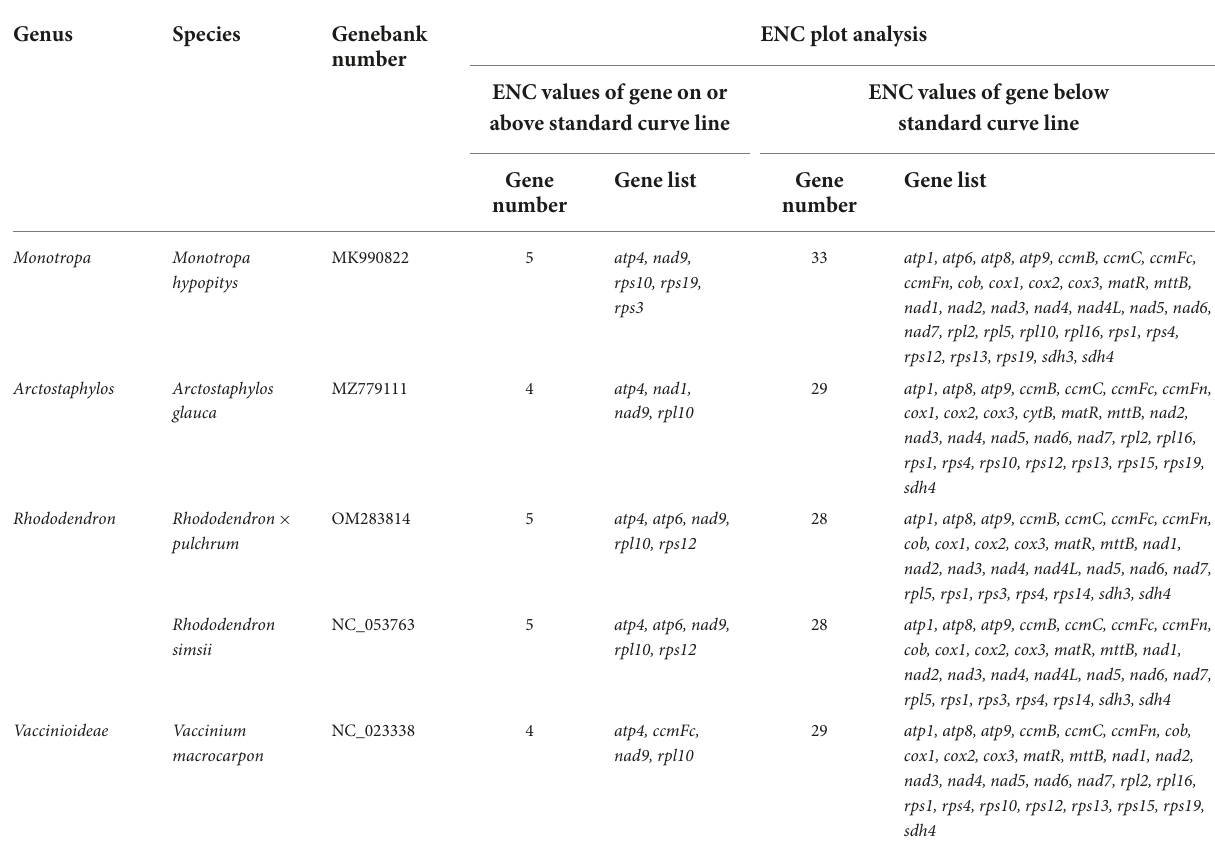
TABLE 3 Plot of ENC of genes in 5 Ericaceae species mitochondrial genomes. Genus Species Genebank